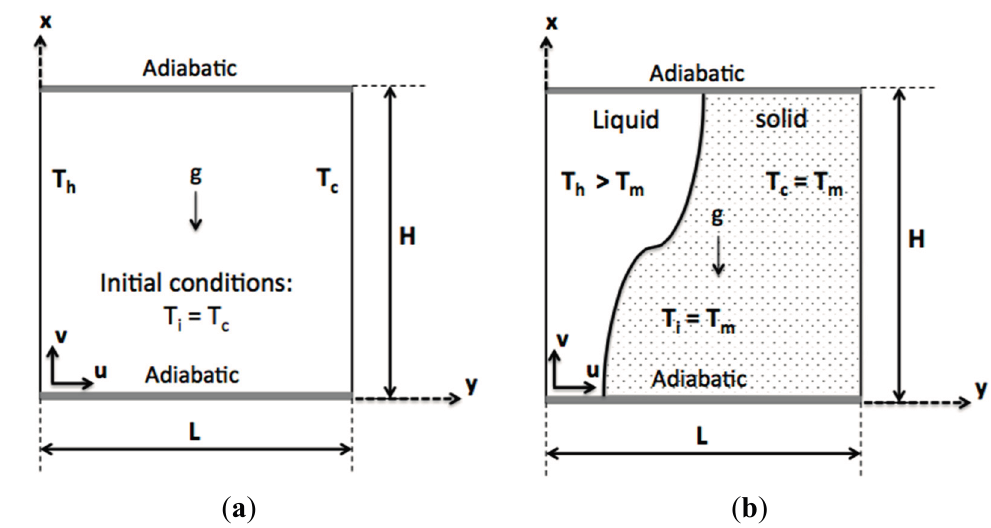
Figure 1. Schematic view of the differentially-heated square cavity with initial and boundary conditions ( a ) Natural convection (no melting); ( b ) melting with